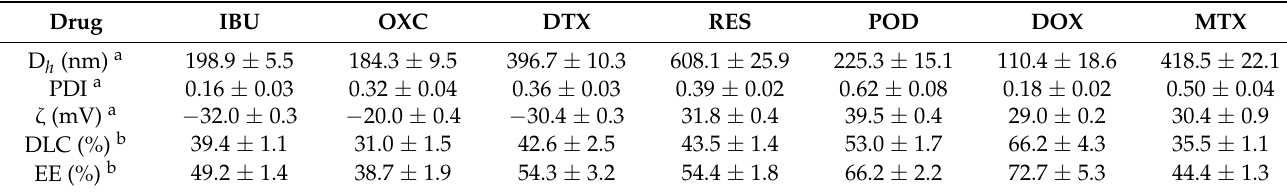
Table 1. Results of the drug-loaded α -PGA